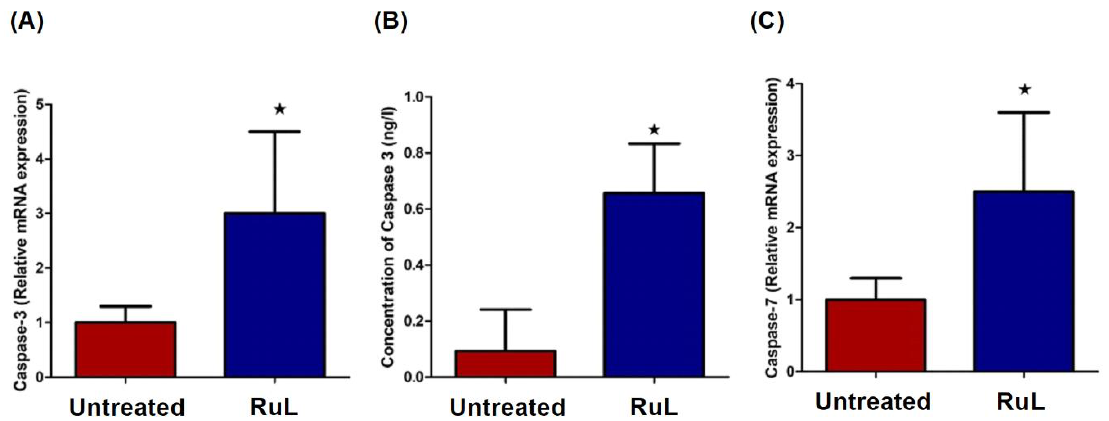
Figure 6. Effect of the RuL complex on the caspase 3 and 7 activities in HepG2 cells: ( A ) expression of caspase 3, ( B ) caspase 3 activity, ( C ) expression of caspase 7. Data are expressed as mean ± SD of two independent experiments performed in triplicate. Statistical differences were analyzed with a t -test. * Significant at p < 0.05.